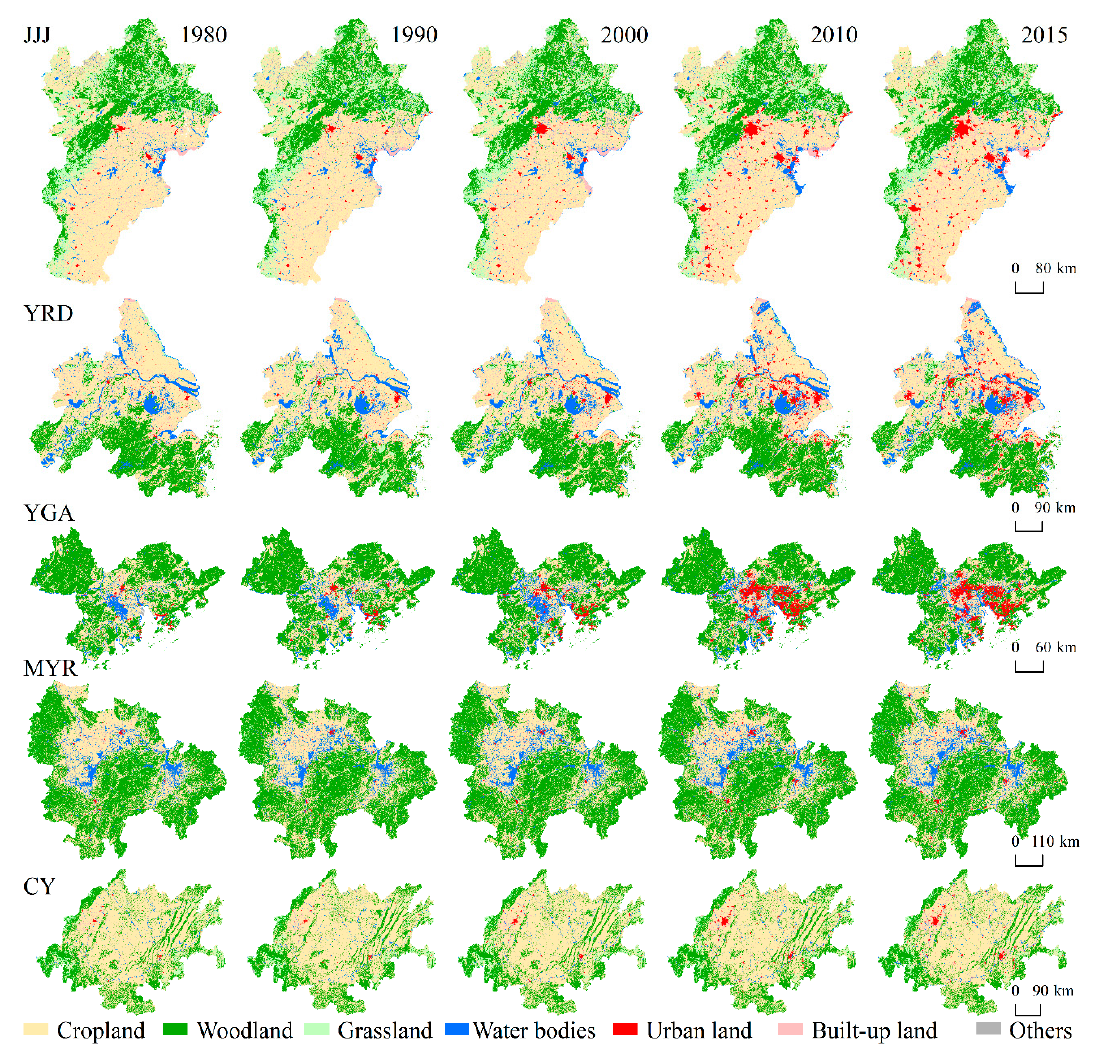
Figure 3. Urban expansion in the five megaregions.